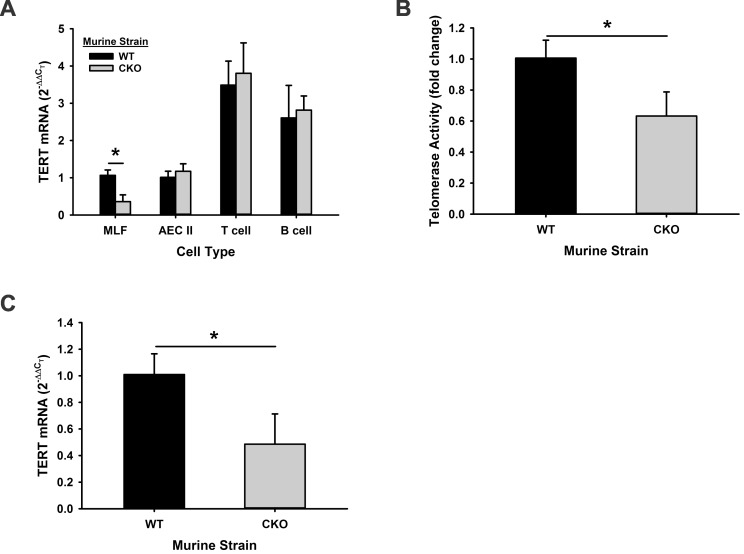
Selective knockout of TERT gene in TERT CKO mice.(A) MLF, AEC II, thymic T, and splenic B cells were isolated from TERT CKO and WT mice. TERT mRNA expression was examined in these cells. n = 3 for each. (B) Telomerase activity was measured in the MLF from TERT CKO and control mice. n = 3. (C) The TERT mRNA expressions in TERT CKO and control lung tissues are shown. n = 3. *, P < 0.05.